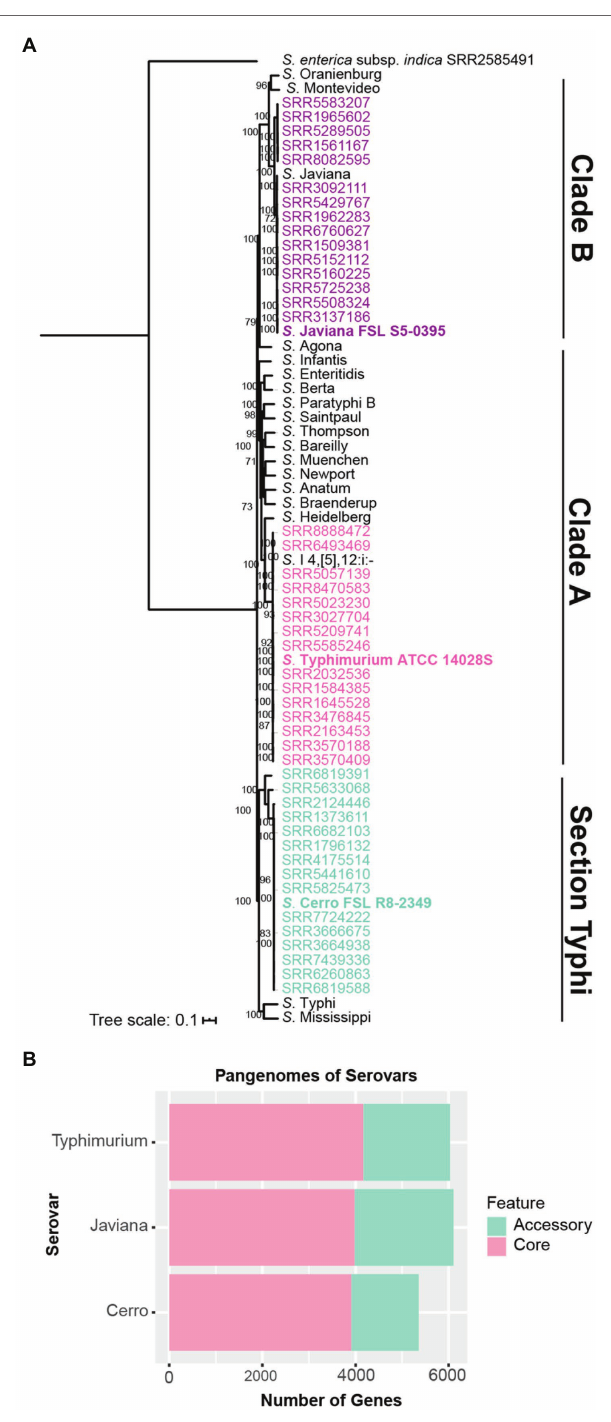
FIGURE 1 | Genomic comparisons identify similar pan genome sizes for broad host range serovars Javiana and Typhimurium, but a smaller pan genome for cattle- associated serovar S. Cerro. (A) Maximum likelihood phylogenetic tree constructed from 55,425 core SNPs identified with kSNP3 for isolates representing NTS serovars Javiana (purple), Cerro (blue), Typhimurium (pink) and 18 additional serovars that represent the most common NTS serovars isolated from human clinical infections in the US; one additional assembly of S. Javiana (shown